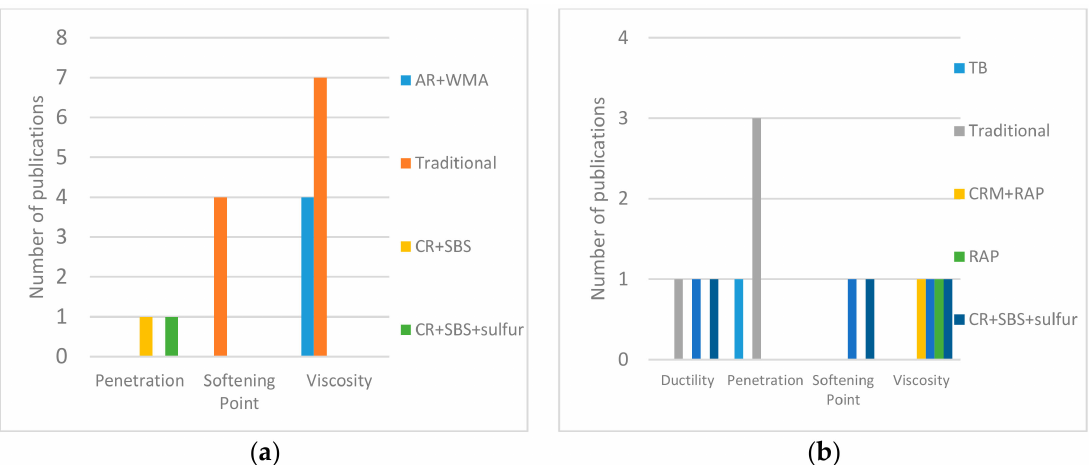
Figure 9. ( a )Numberofpublicationswheretheresultsreportahighervalueoftheanalyzedcharacteristicof